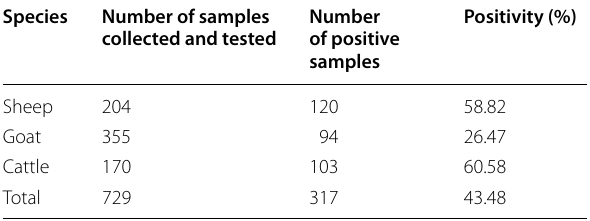
(Table 6). Presence of anti-bluetongue virus antibodies was found highest in cattle population followed by sheep and goat. The prevalence in different agro climatic zones ranged between 30–50%. Incidence of bluetongue in animals of Assam being not reported so far; the present seroprevalence status of bluetongue in Assam indicates presence of sub-clinical infection in the state for the first time (Joardar et al., 2013).